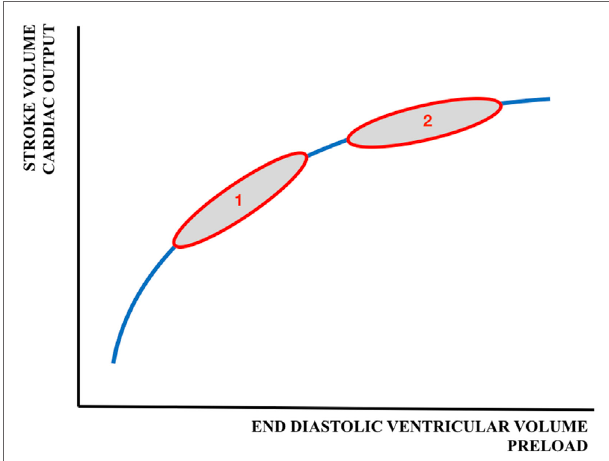
FigURe 3 | Schematic representation of the Frank–Starling curve. 1 = adult cardiac function; 2 = fetal/neonatal cardiac function. A similar change in preload will result in a larger increase in cardiac output/stroke volume in adults than in